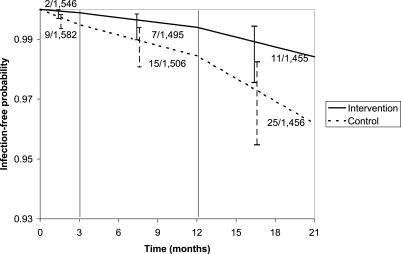
Infection-Free Probability As a Function of Time and of RandomizationThis figure represents the infection-free probability using a piecewise exponential distribution with boundaries at M3, M12, and M21 obtained with a Poisson log-linear model (see text). Each segment of exponential has been fitted to the data in each period for each randomization group. The 95% confidence intervals have been represented in the middle of each period. x/y is the number of HIV infections observed in each period (x) and the number of persons at the beginning of the period (y).